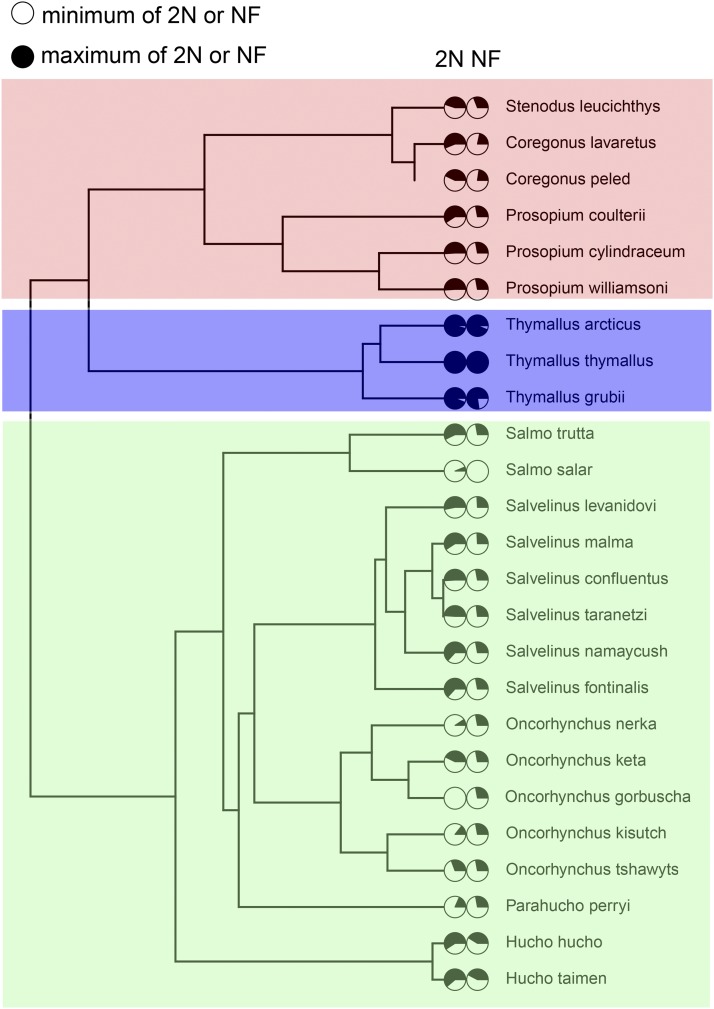
Karyotypic changes among salmonid taxa. A Bayesian chronogram tree based on mitochondrial sequence (tree obtained and edited from Shedko et al. (2013), doi: 10.5061/dryad.r42qf) of those salmonids that have diploid chromosome number (2n) and the number of chromosome arms (NF) available in Phillips and Ráb (2001).